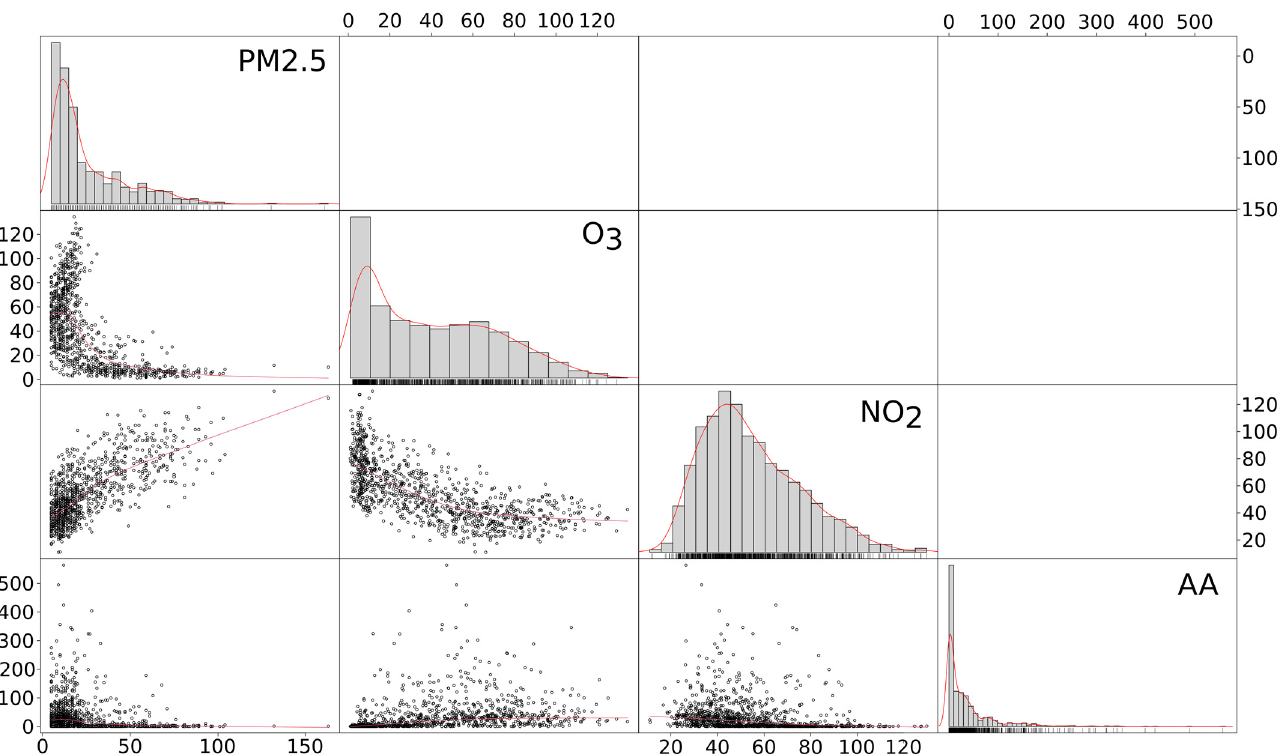
Figure 4. Matrix correlation plot among pollutants under analysis. The red lines over histograms represent the density function of that variable distribution. The red straight lines in scatter plots represents the correlation r 2 splope between the pollutants plotted in each scatter plot. AA: aeroallergens.